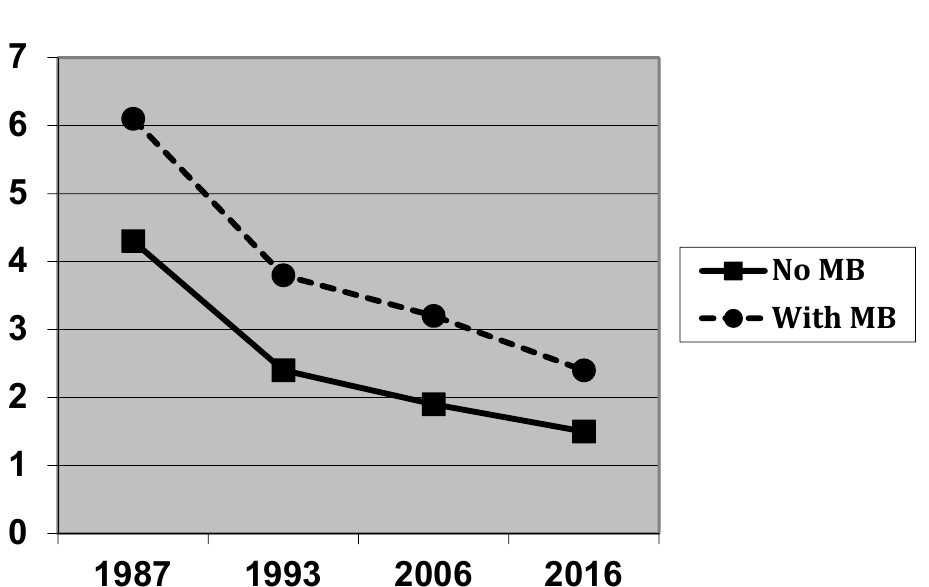
Figure 2. Caries experience (dmft including initial caries) in preschool children in Hamburg 1987– 2016, related to the children’s migration background (MB).